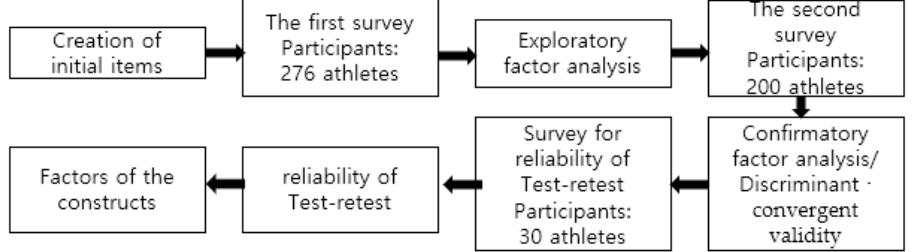
Figure 1. The procedure over time.